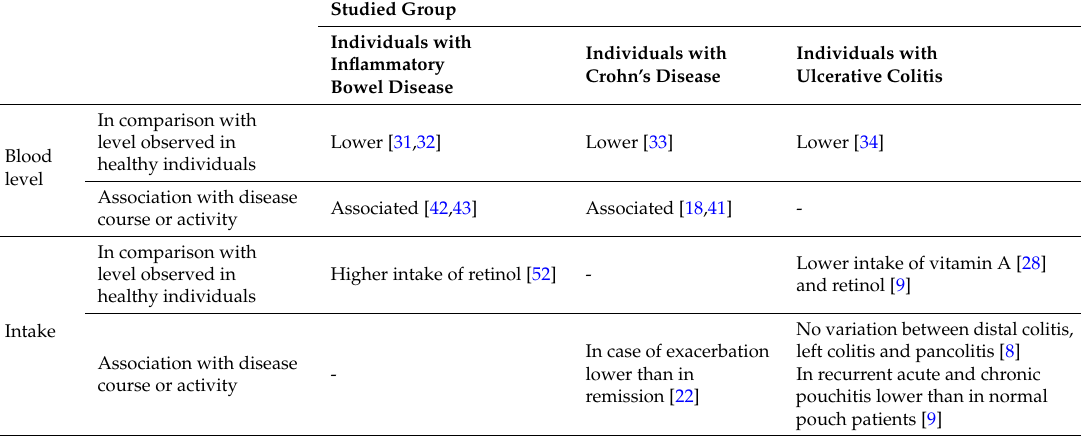
Table 5. Summary table of human studies comparing vitamin A blood level or intake observed in inflammatory bowel disease and healthy individuals, as well as analysing associations between vitamin A blood level or intake and disease course or